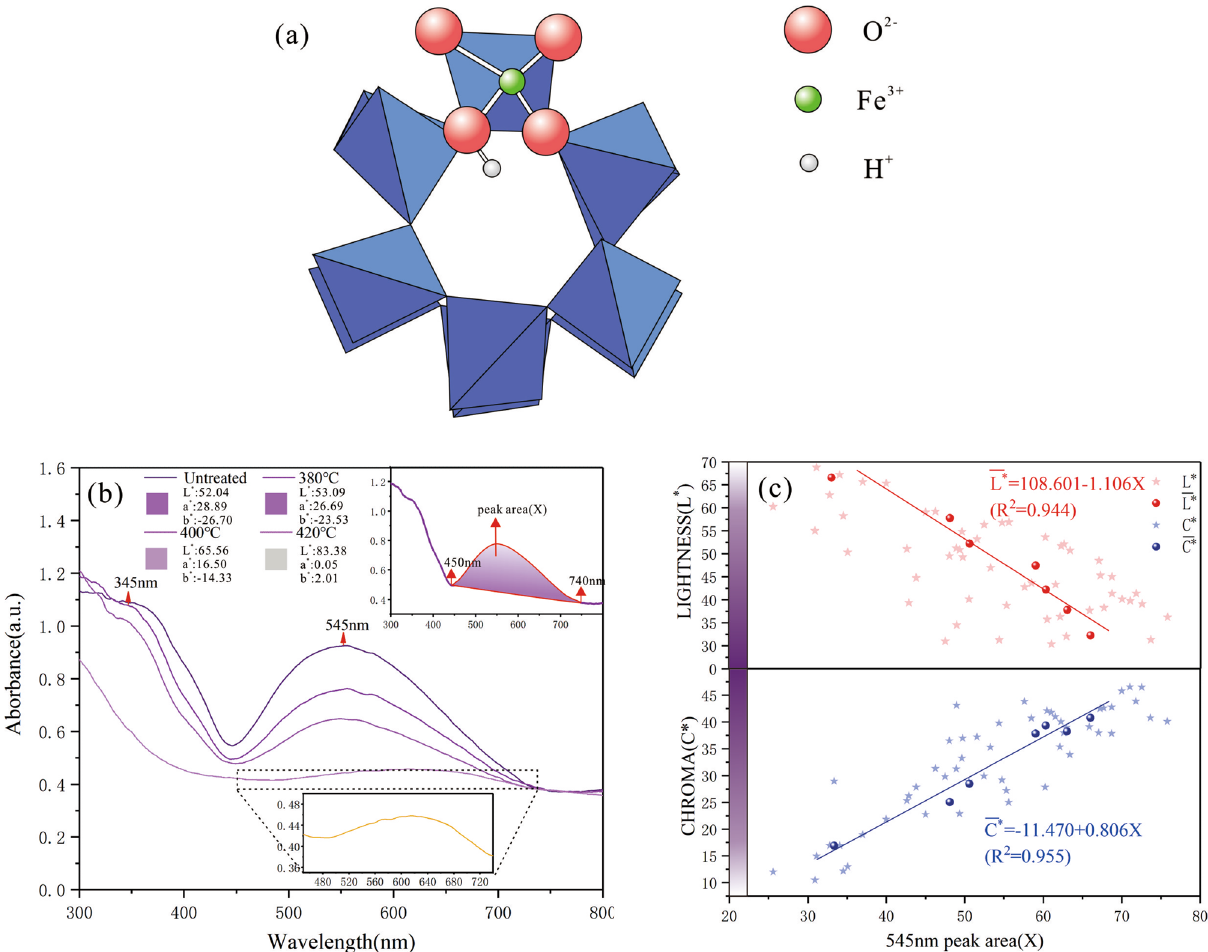
Figure 3. ( a ) Structural models of the Fe substitutional sites, obtained from DFT calculations 38 : the Fe 3+ , H + are shown with the channels along the c-axis projection. In the model, Fe bonds three O ions at 1.81 and the fourth (bonded to the proton) at 2.06 . ( b ) The UV–Vis spectra of amethysts heated at different temperatures. Å The top right is the peak area (X) at 545 nm obtained by integrating from 450 to 740 nm. (c) The relationship Å between peak area (X) at 545 nm and lightness (L*) and chroma (C*). The larger the peak area (X) at 545 nm is, the darker the color of the amethyst. The figures were drawn using the OriginPro 2017C Beta b9.4.1.268 (https :// www.Origi nLab.com.) and CorelDRAW Graphics Suite X8 2016 18.0.0.405 (https ://www.corel